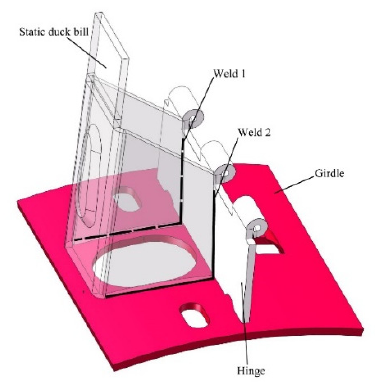
4 of 16 Table 1. Structural parameters of duckbill welding parts. Parts 39.281 Table 2. Material properties of Q235.